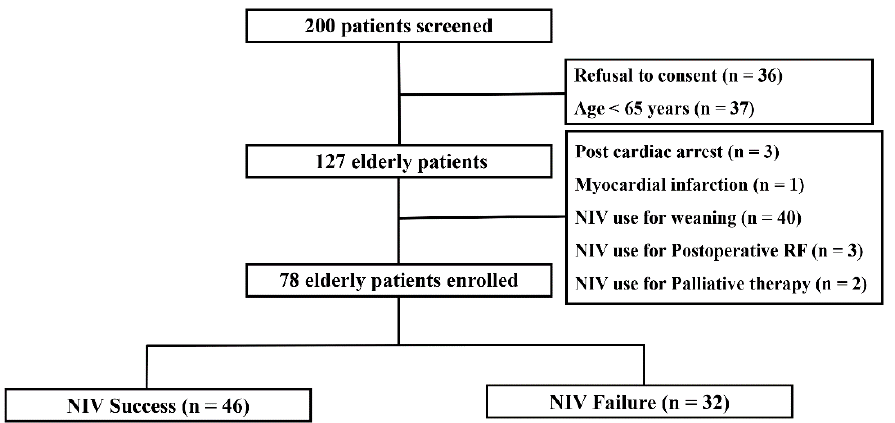
Figure 1. Flow chart of enrolled patients. NIV, noninvasive ventilation; RF, respiratory failure.